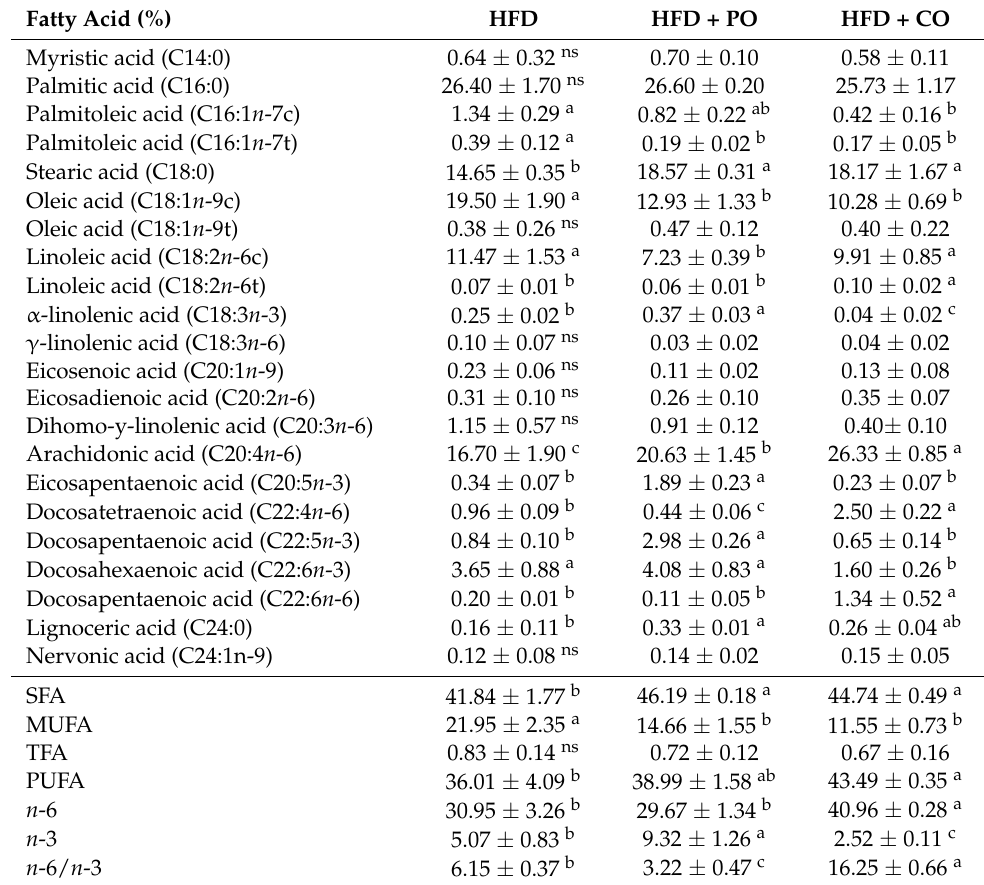
Table 7. Fatty acid composition of the whole blood of